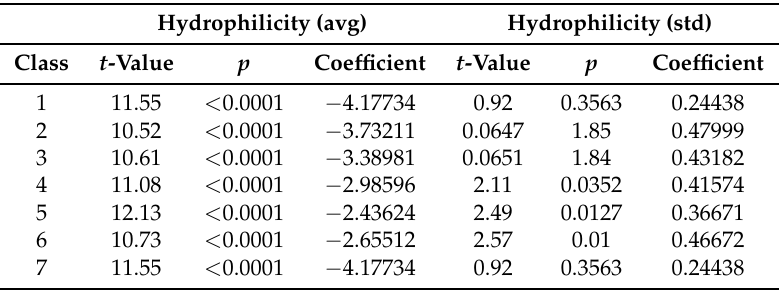
Table 6. Hydrophilicity contribution to score for different classes.